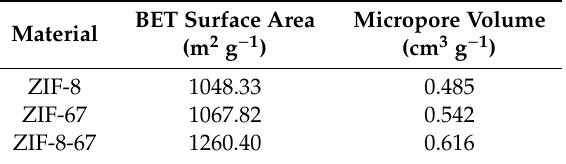
Table 1. Zeolitic imidazolate framework (ZIF) porosimetry data.